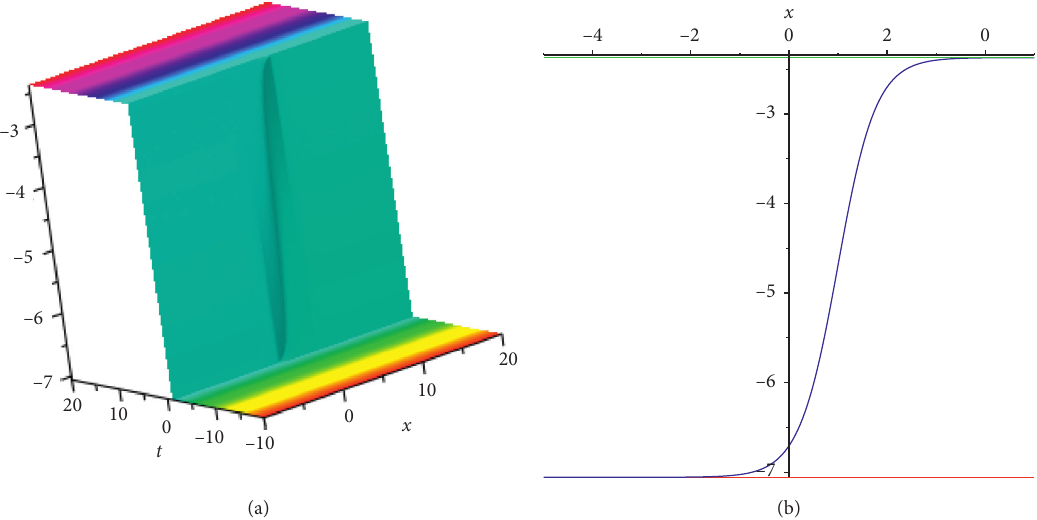
( x, y, t ) at A � 1 , B � 2 ,a � 3 ,b � 2 ,k � 1 . 5 , ω � 2 , β � 3 , c � − 1 ,y � 2 , and α � 1 for (a) 3D plot and (b) 2D 1 0 0